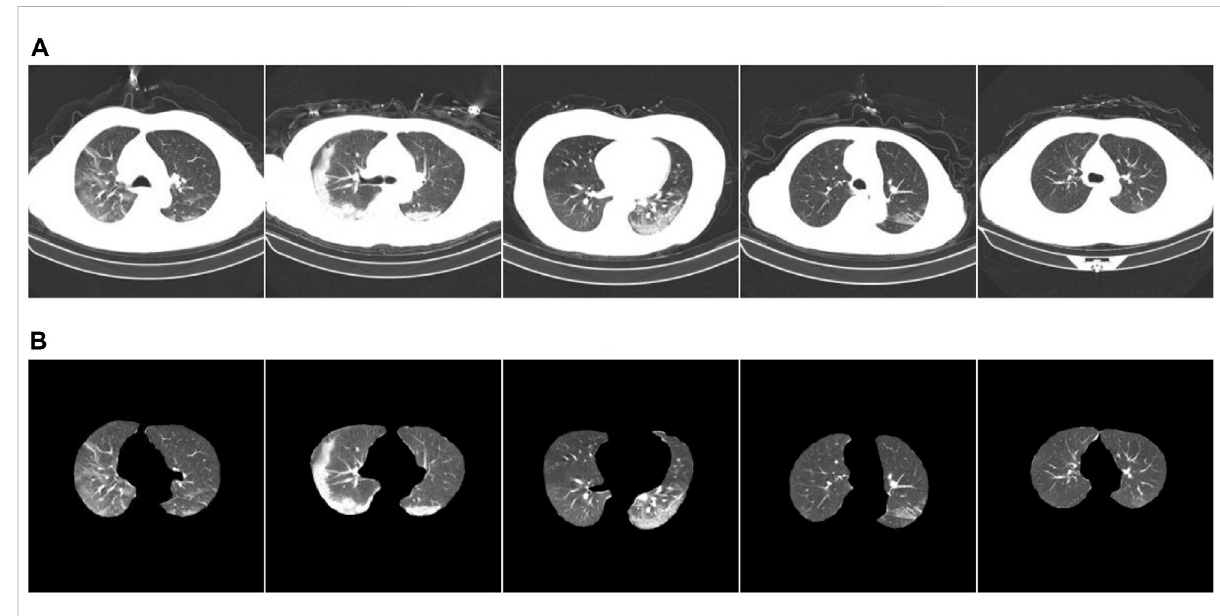
FIGURE 6 Example of ablation experiment comparison. (A) The CT image of the COVID-19 patient; (B) the result.